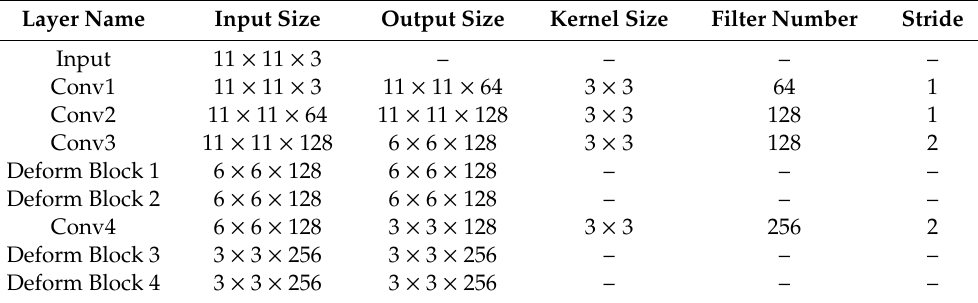
Table 3. Detailed configuration of the MDCN.